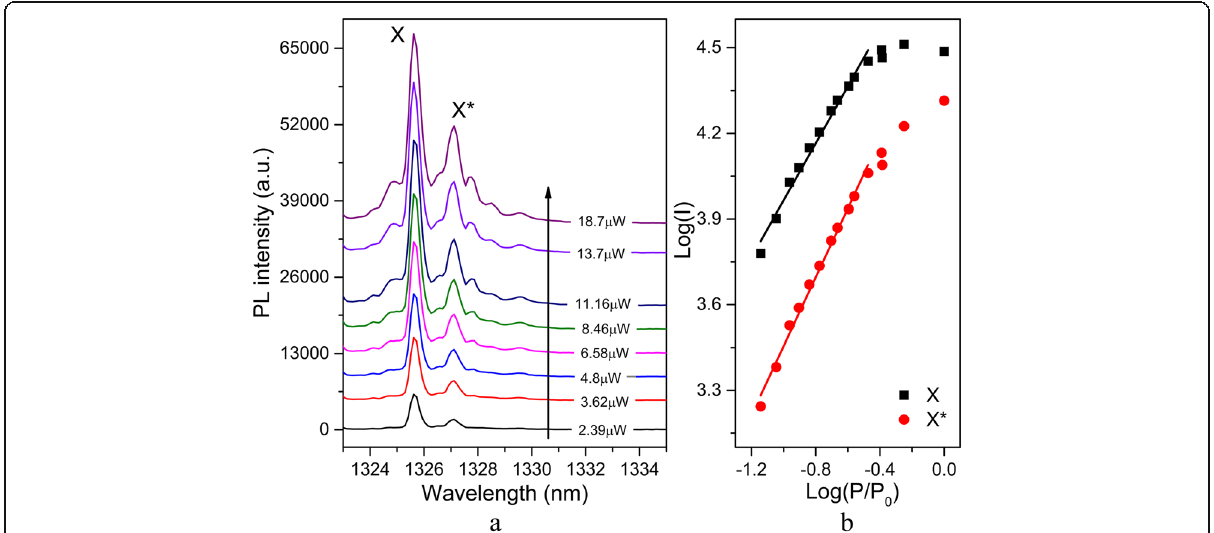
Fig. 3 a Excitation power-dependent μ PL spectra ( T = 4 K) of typical BQDs in micropillar. b Integrated PL intensity of exciton (X) and charged